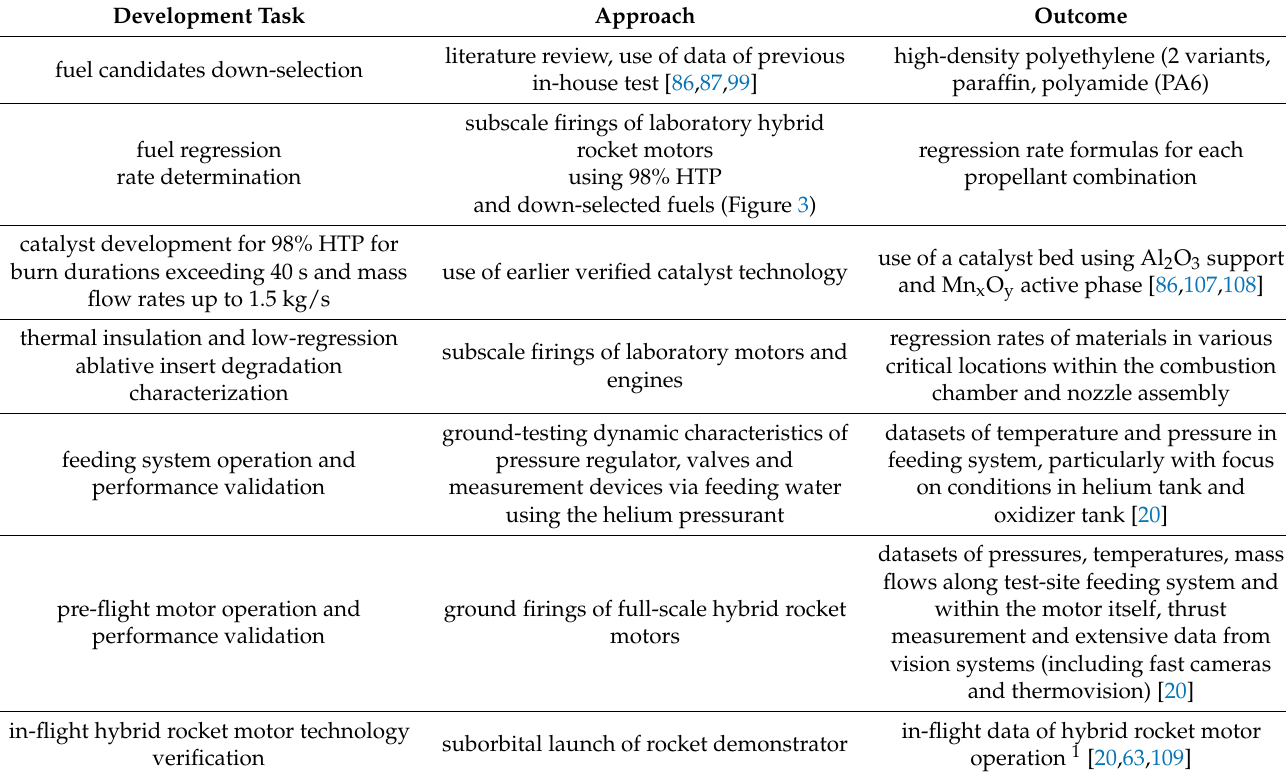
Table 2. Key methods—propulsion technology development for the ILR-33 AMBER